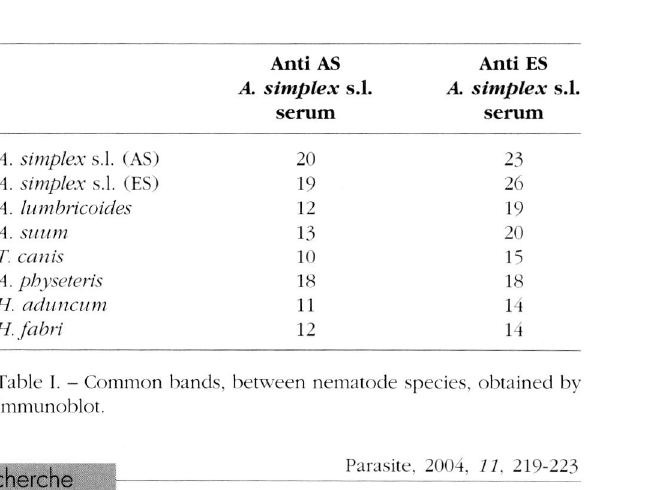
Table I. - Common bands, between nematode species, obtained by